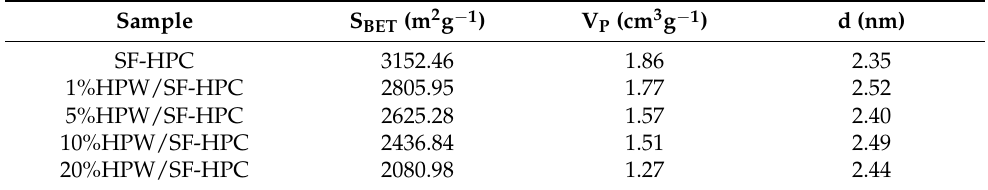
Table 1. Structure parameters of the